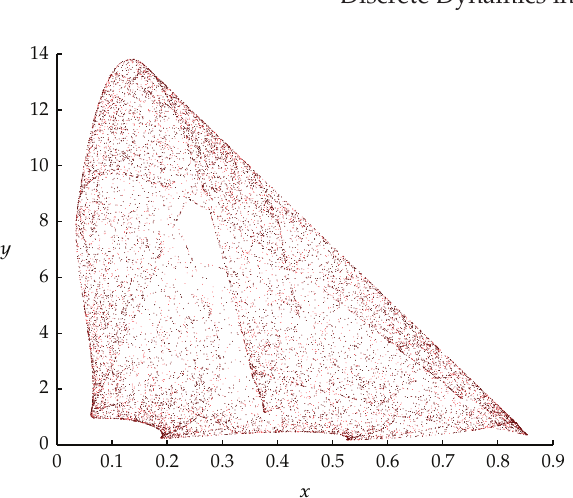
Figure 24: Chaotic attractor for the system (cid:3) 2.2 (cid:4) for a (cid:8) 3 . 5, b (cid:8) 0 . 2, and d (cid:8) 3 .